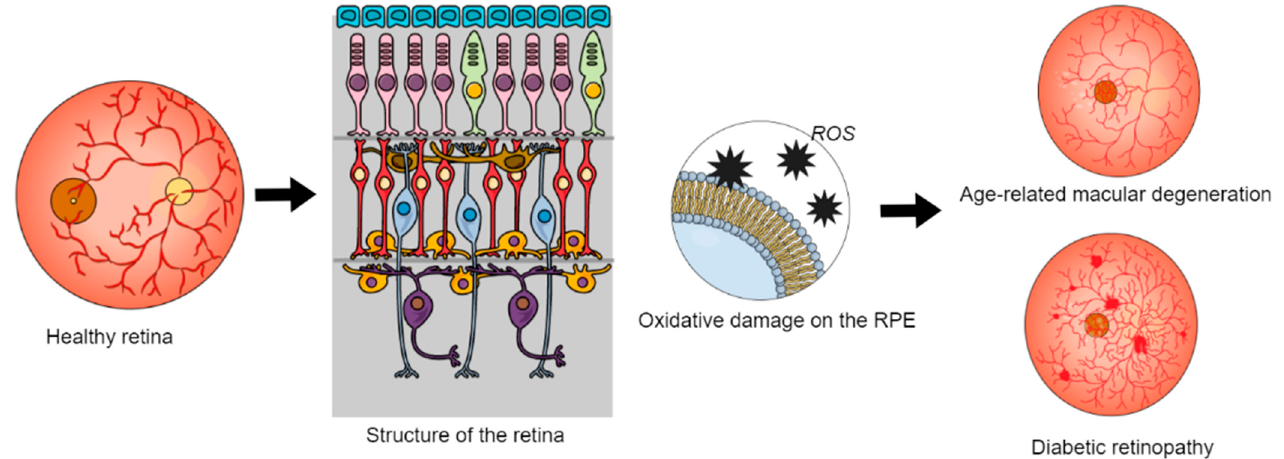
Figure 1. Accumulation of oxidative damage on the RPE causing age-related macular degeneration and contributing to the progression of diabetic retinopathy. (Source: authors’ own drawing).